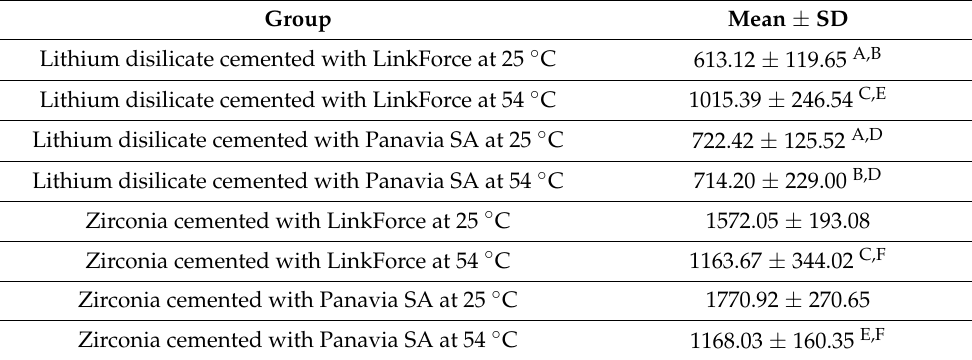
Table 2. Means and standard deviations of the fracture resistance (N) for studied groups. Group Mean ± SD